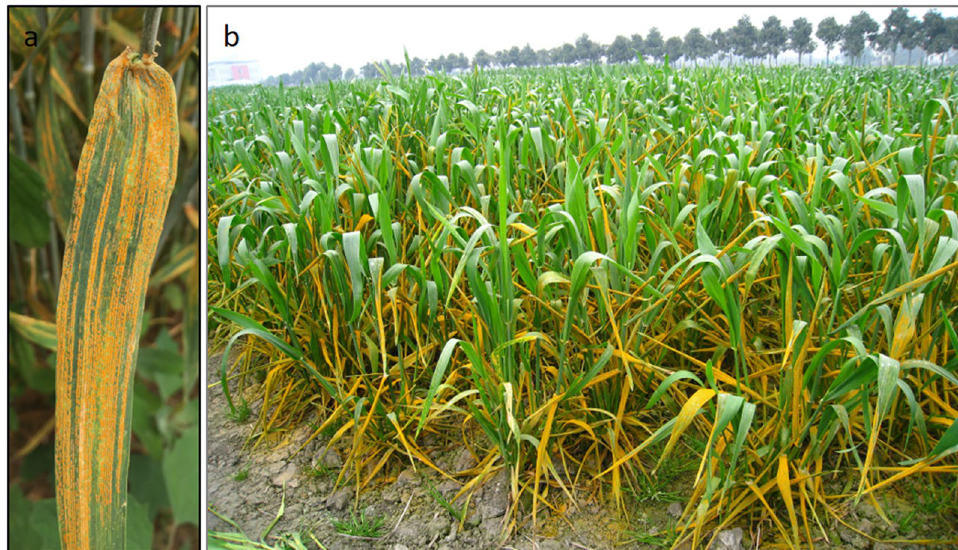
Fig. 1 Single stripe signs of uredia between leaf veins of wheat stripe rust ( a ) and a nursery field showing severe stripe rust infection on wheat plants at elongation stage in Mianyang, Sichuan on March 18, 2011 ( b )